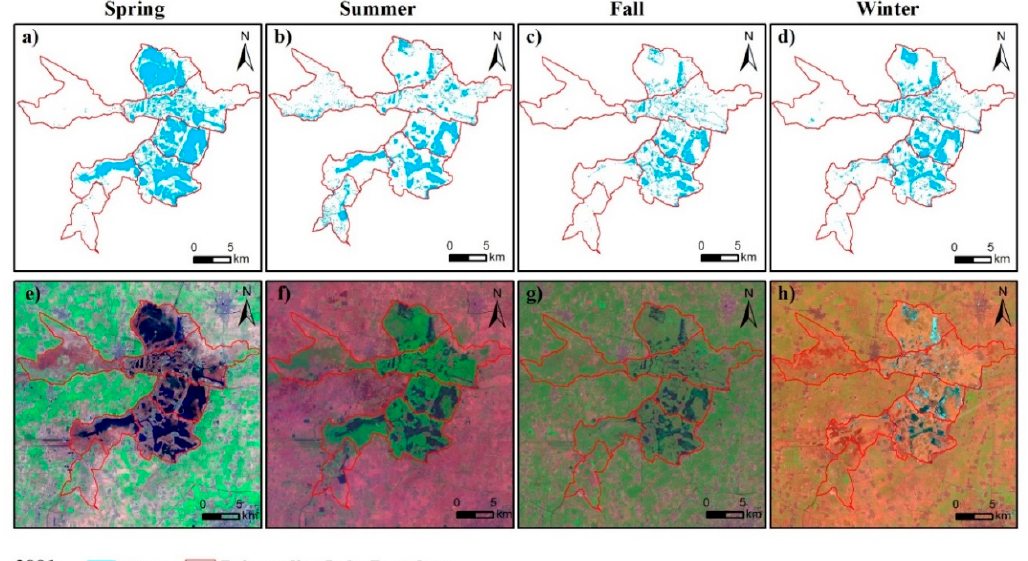
Figure 7. Comparison of water extraction results and original images for all four seasons in 2001. Extracted water surface in the ( a ) spring, ( b ) summer, ( c ) fall, and ( d ) winter of 2001. False color images (bands: 6, 4, and 2) of ( e ) spring, ( f ) summer, ( g ) fall, and ( h ) winter in 2001.